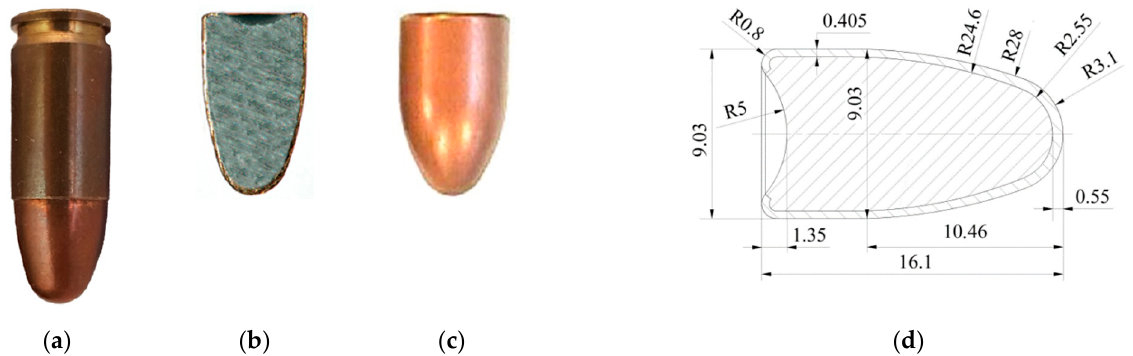
Figure 6. The 9 × 19 mm FMJ Parabellum bullet: ( a ) single cartridge; ( b ) projectile cross section; ( c ) projectile and ( d ) dimensions of projectile.